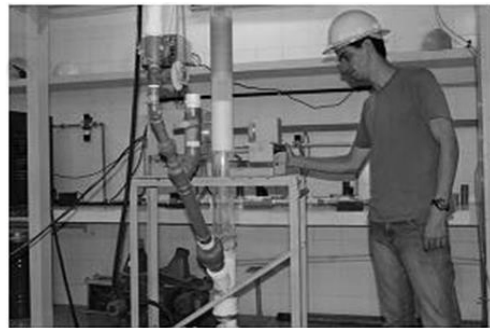
Fig. 1. Cold Pilot Unit – Instrumental set